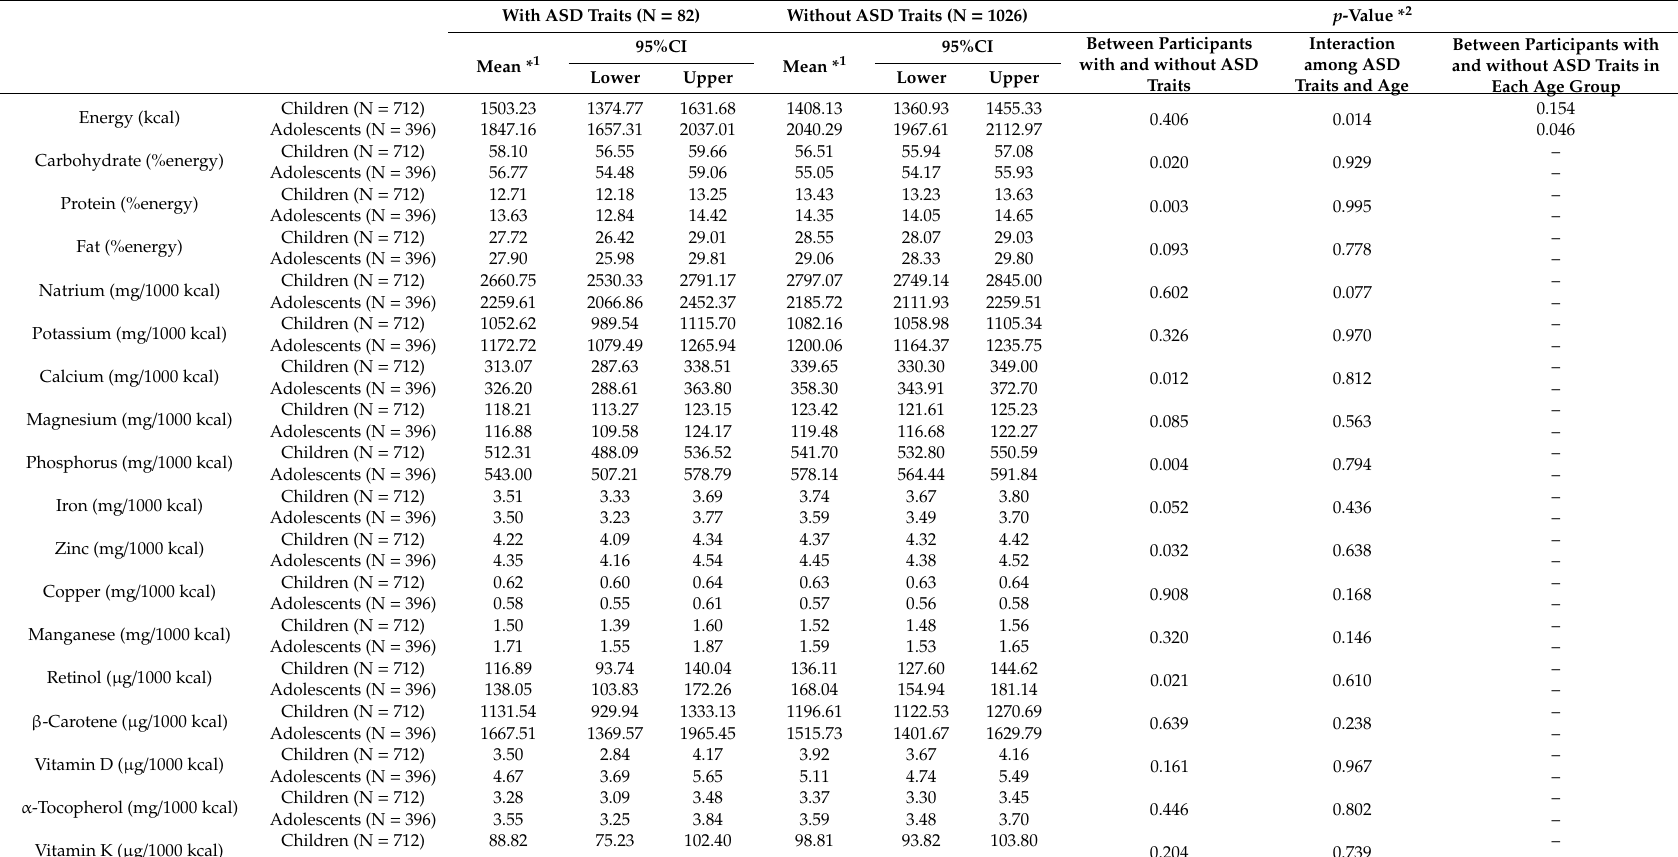
Table 3. Comparisons of the nutrient intakes among participants with and without ASD traits in di ff erent age